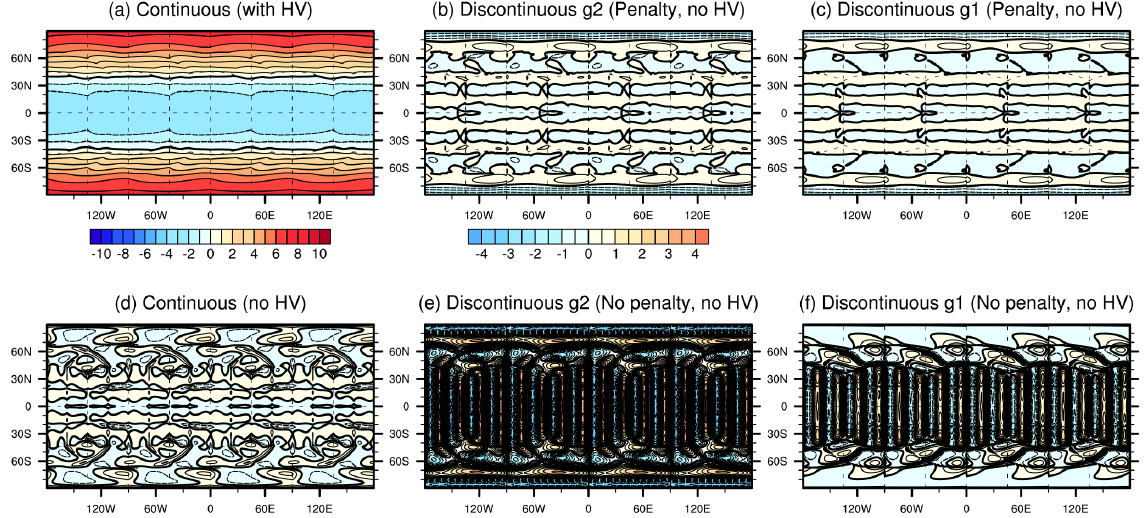
Figure 3. L 2 errors in Williamson et al. (1992) test case 2, steady-state geostrophically balanced flow for n e = 4 and n p = 4 after a 5-day integration period. Contour spacing for plot (a) is 1m. Contour spacing for all other plots is 0.5m. The zero line is enhanced. Long dashed lines show the cubed-sphere